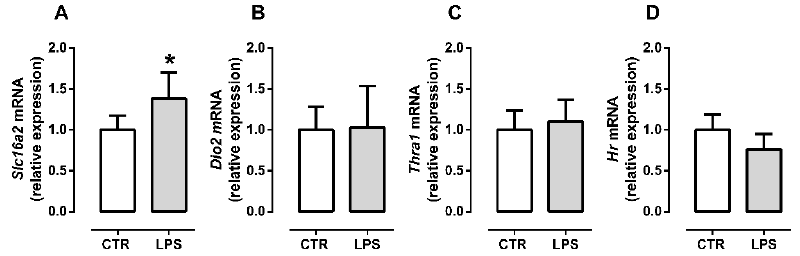
Figure 4. LPS increases TH transporter expression in C2C12 myocytes/myotubes during late differentiation. Expression Slc16a2 ( A ), Dio2 ( B ), Thra1 ( C ), and expression TH responsive-gene Hr ( D ) in C2C12 myocytes/myotubes mixed culture at 96 h post differentiation induction. The white bar represents the control group (CTR), and the gray bar represents the LPS group (LPS, 10 ng/mL). Data are expressed as mean ± SD of at least five independent experiments The data normal distribution was confirmed by D’Agostino and Pearson omnibus test; the parametric Student’s t-test was applied. * p < 0.05.